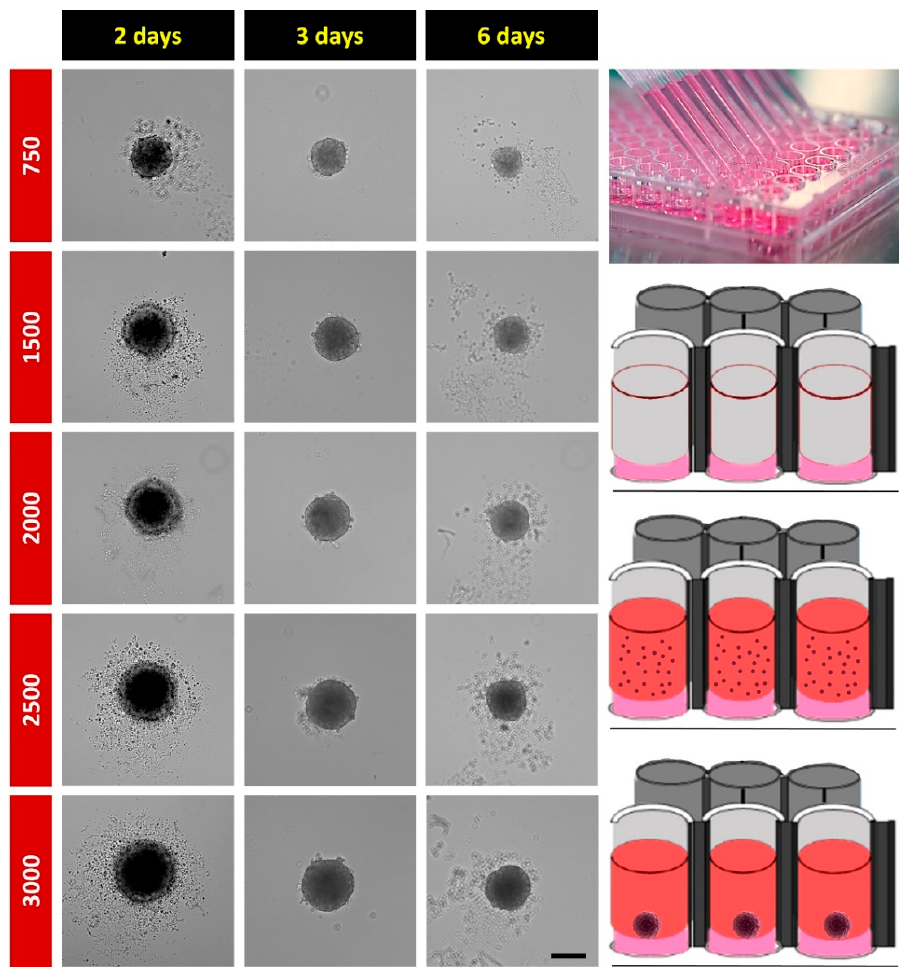
Figure 1. Left panel: bright-field images of H32 neurospheroids with 750, 1500, 2000, 2500, or 3000 initial cells following 2-, 3-, and 6-day in vitro cultures. On Day 3, the spheroids were fully formed and started to decay from there on. Therefore, all experiments were conducted within 3 days. Scale bar: 100 µm; right panel: schematic experimental outline of the spheroid formation.